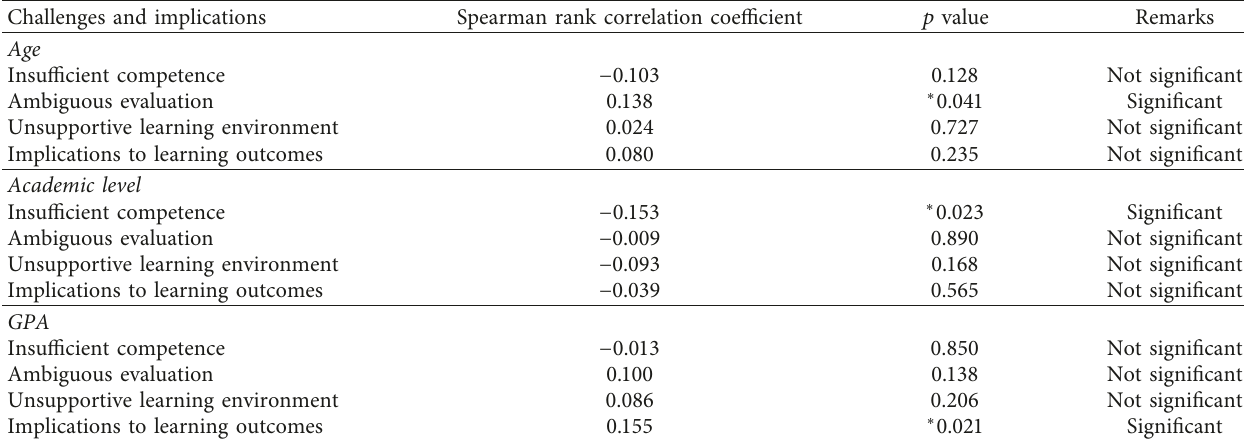
Table 4: Relationship of age, yearly academic level, and GPA towards clinical challenges and